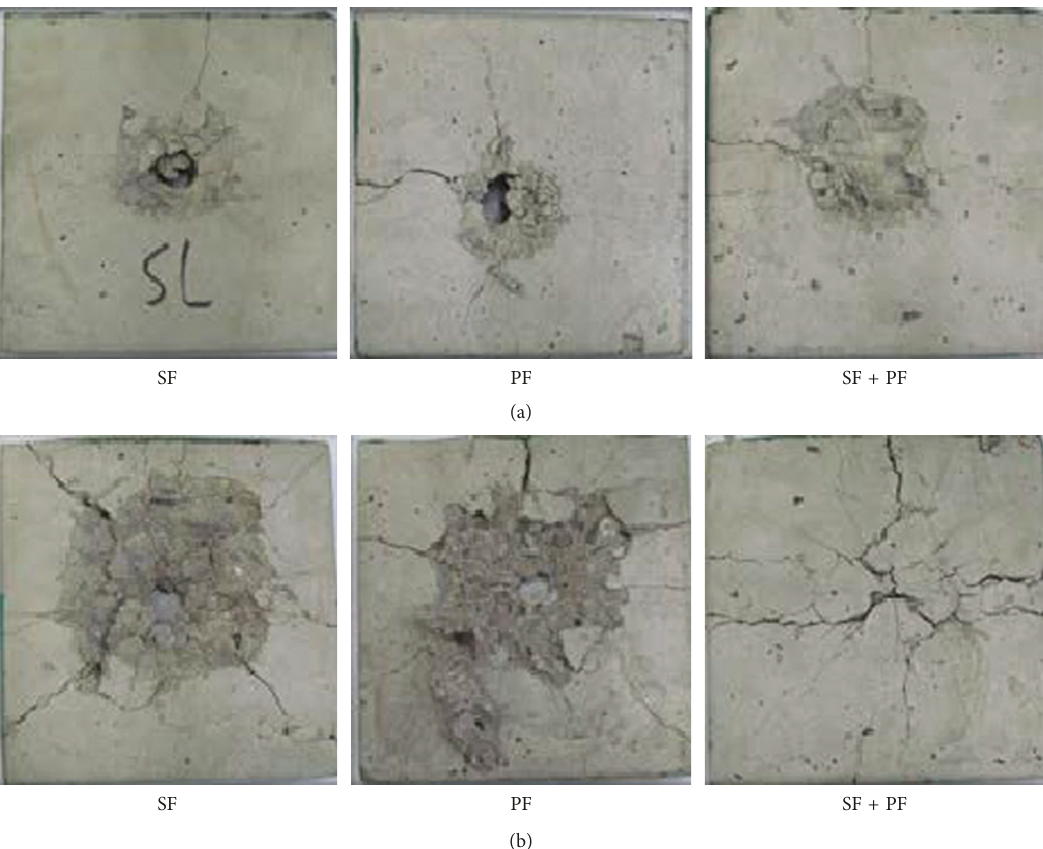
Figure 10: Influence of fiber combination on protecting performance of the concrete panel against the impact test. (a) Impacted side (front). (b) Back side.